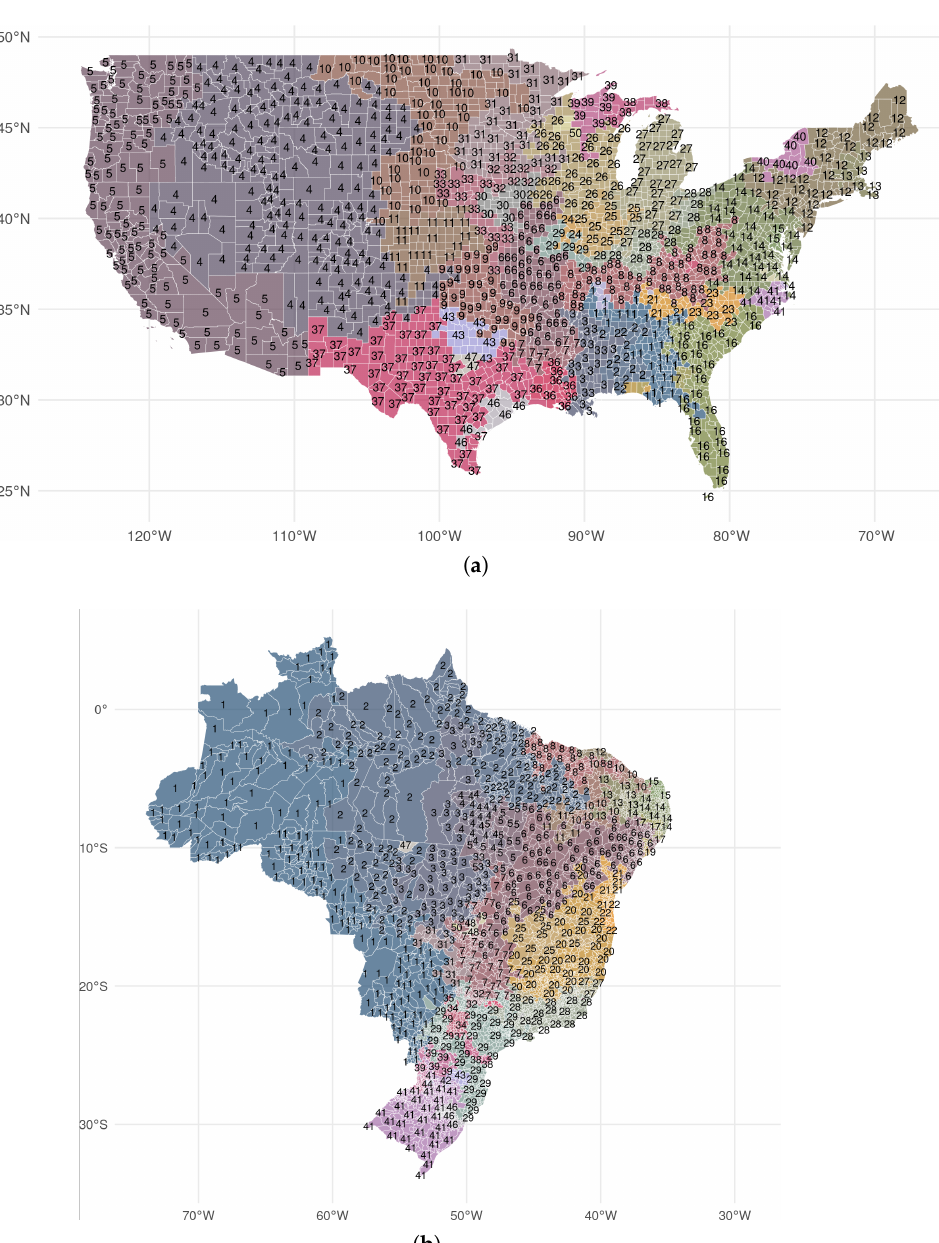
Figure 4. Examples of spatially contiguous random partitions. ( a ) USA: Partition 1 for 50 administra- tive units, ( b ) Brazil: Partition 1 for 50 administrative